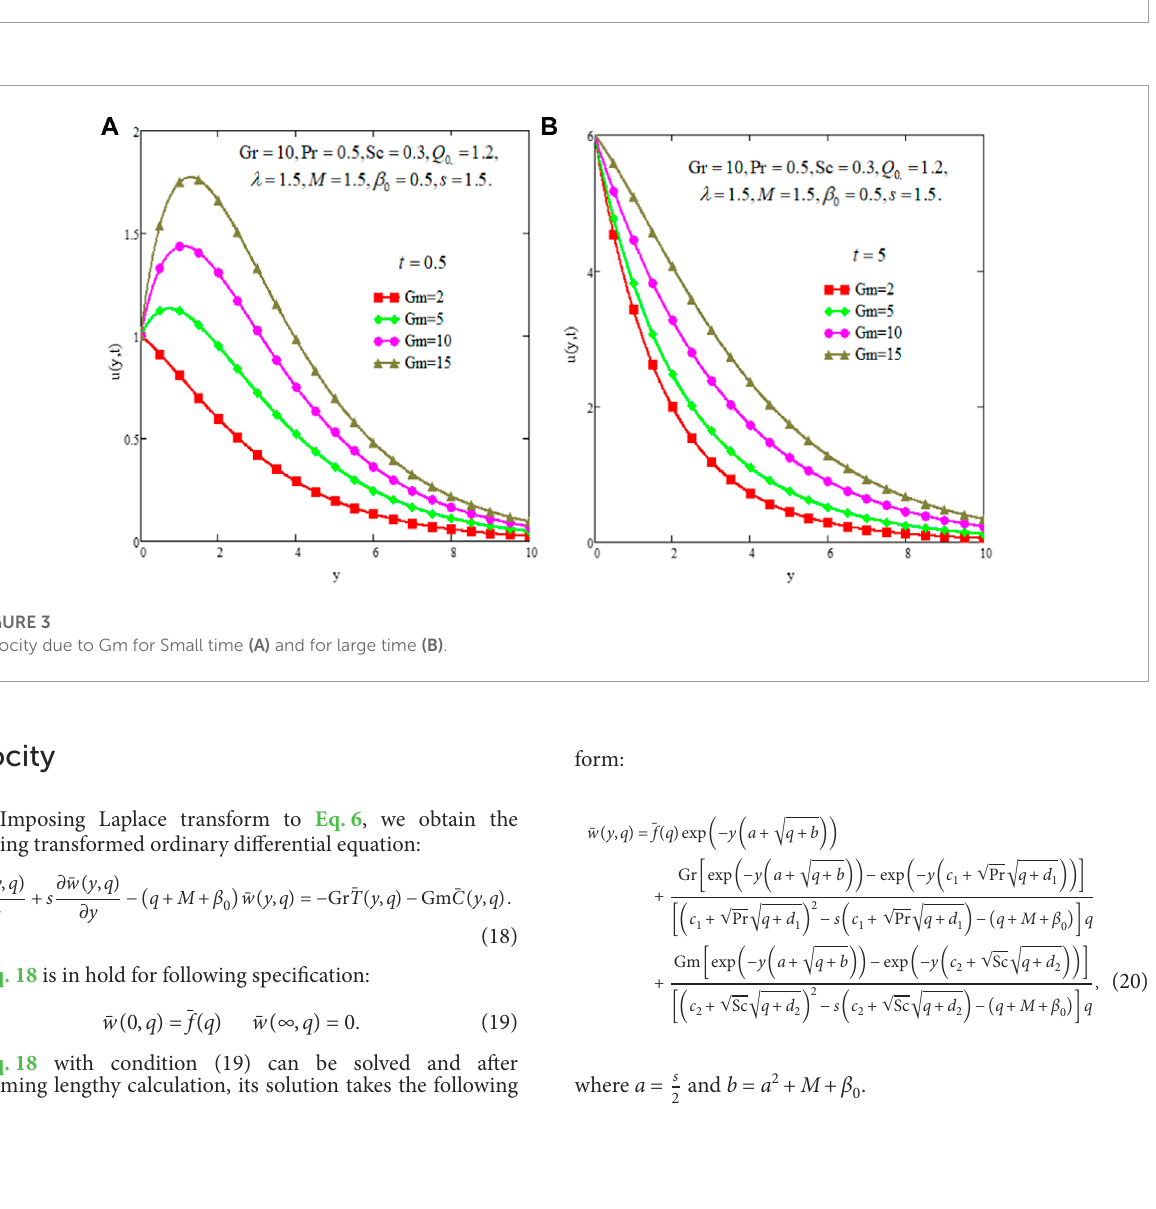
FIGURE 2 Velocity due to Gr for small time (A) and for large time (B) .